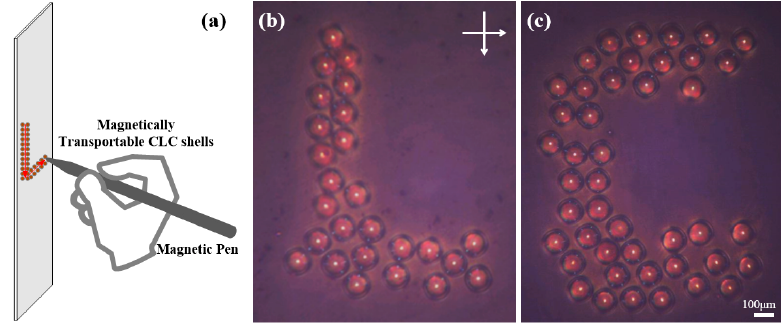
Figure 5. ( a ) Schematic diagram of controlling microshells by a magnetic pen; ( b , c ) POM images of the microshells arranged into English letters “L” and “C”.